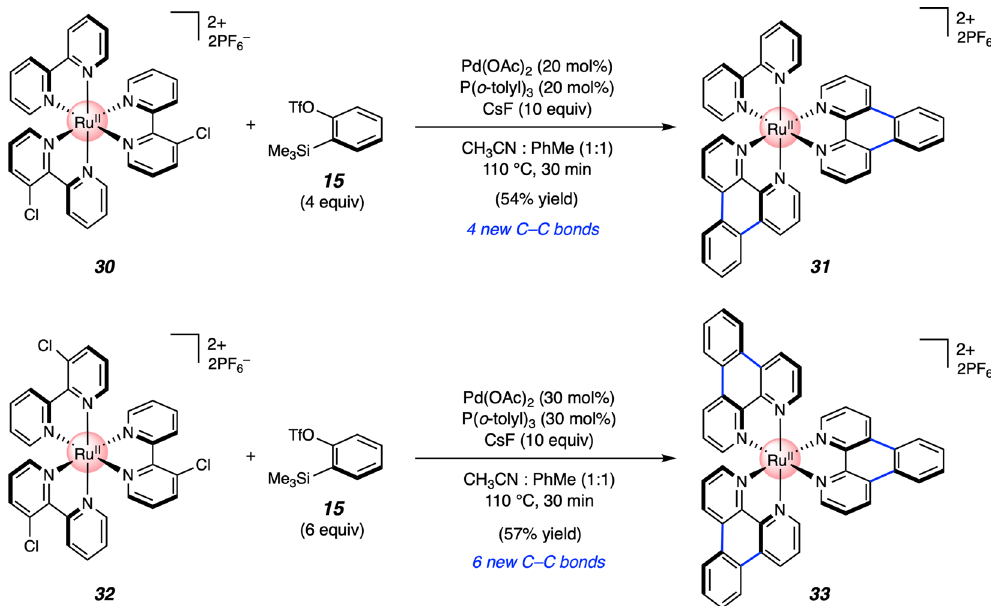
Fig. 6 Pd-catalyzed aryne annulation at multiple sites of Ru complexes. Yields shown re fl ect the average of two isolation experiments. OTf, tri fl uoromethanesulfonate.